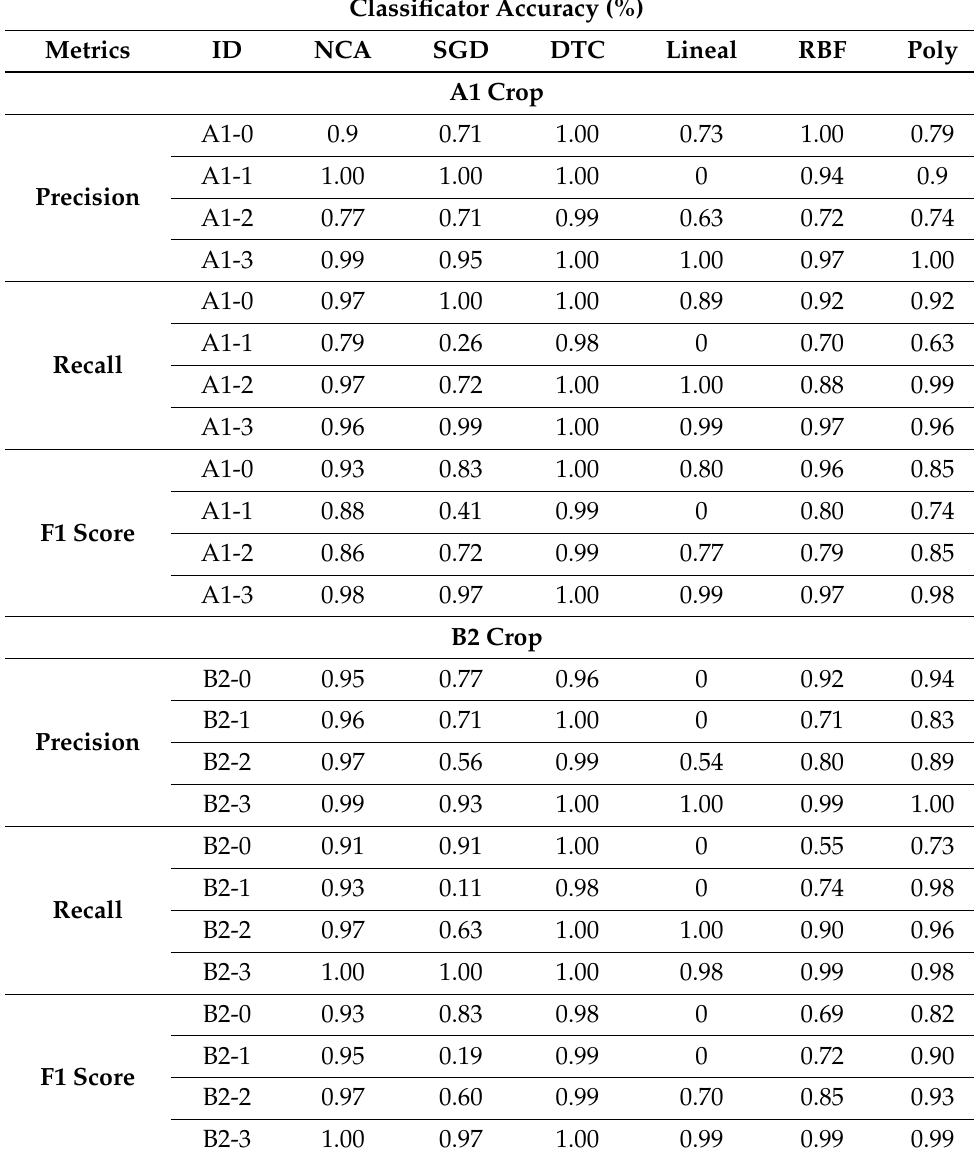
Table 5. Results for the three test crops named A1, B2, C3 and a weighted